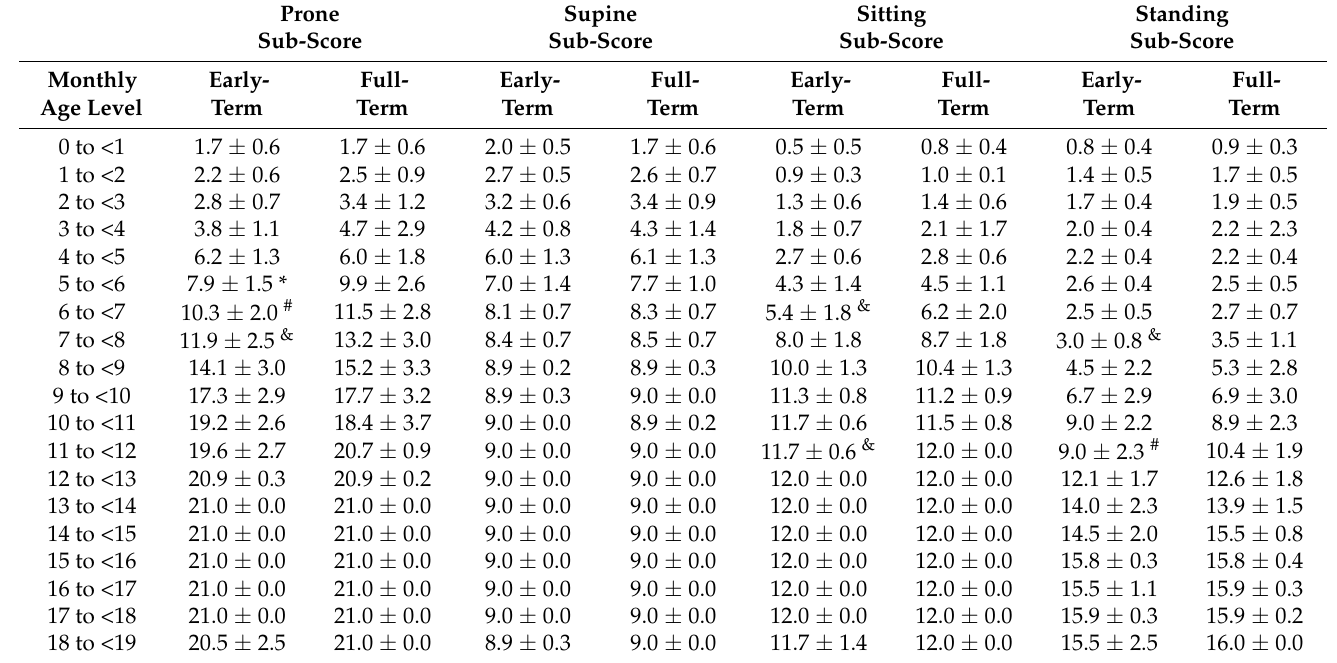
Table 2. AIMS subscales scores (mean ± SD) in early-term and full-term infants according to monthly age level.